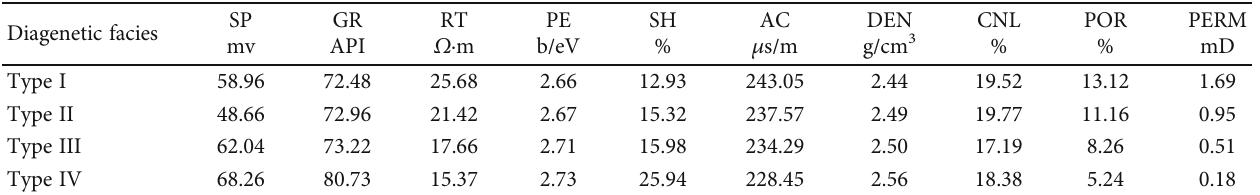
Figure 9: Characteristics of the four types of diagenetic facies logging curves identi fi ed by lithoelectric calibration in the Chang 8 in the study area. (a) Type I: chlorite coating residual intergranular pore diagenetic facies; (b) type II: illite-siliceous cemented dissolved pore diagenetic facies; (c) type III: chlorite- fi lled-carbonate cemented microporous diagenetic facies; (d) type IV: carbonate cemented, compacted, and dense diagenetic facies. Table 7: Logging characterization of four types of diagenetic facies in the YPA and APA. Diagenetic